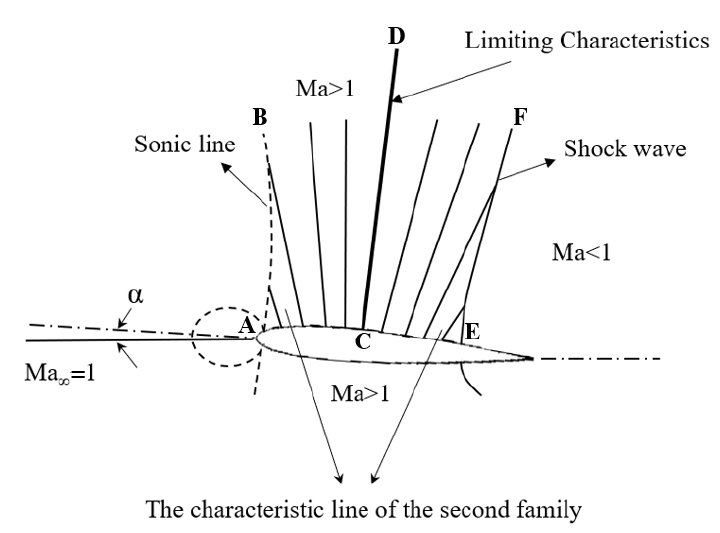
Figure 1. Limiting characteristics at the speed of sound